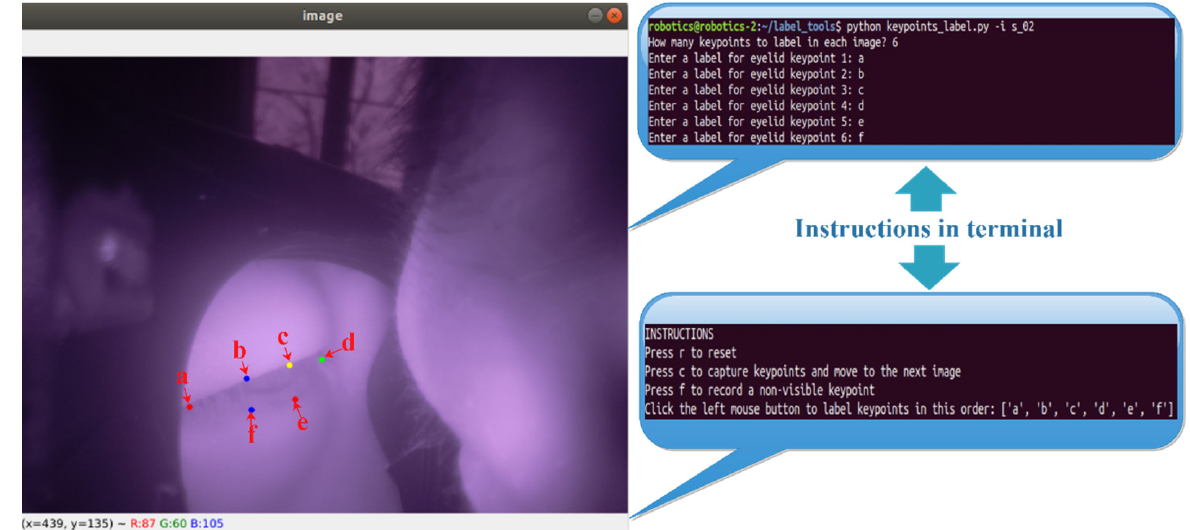
Figure 6. The labeling tools we used to annotate the image with eyelid keypoints.